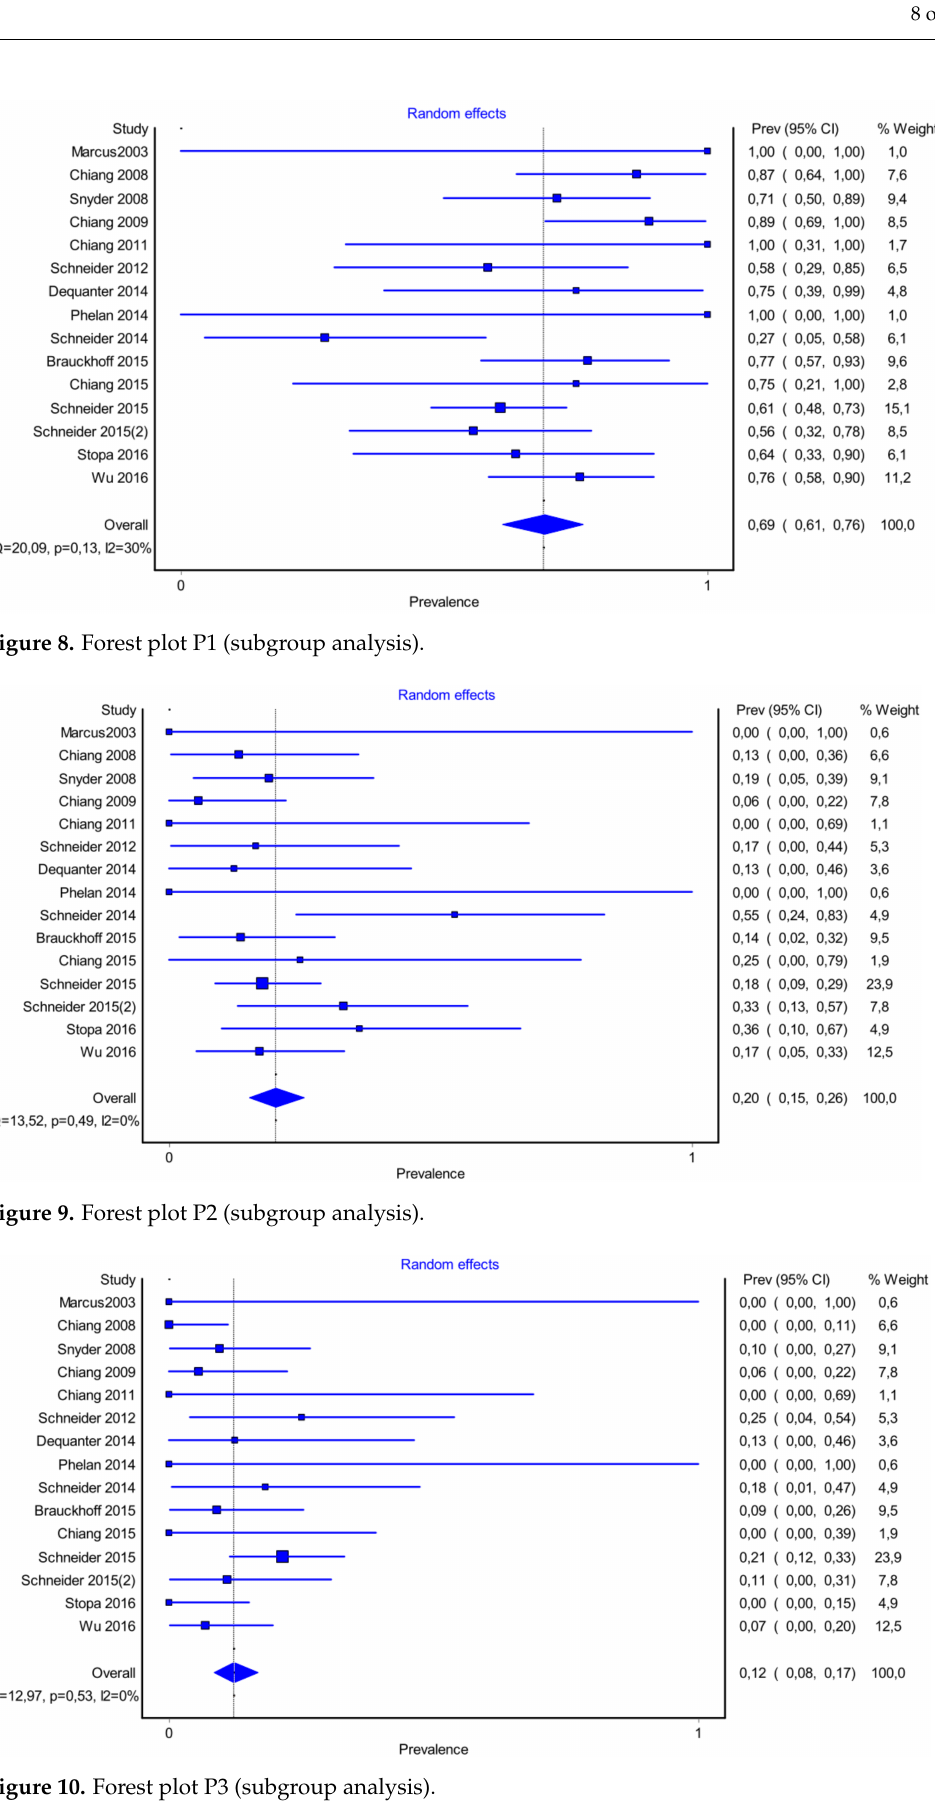
Figure 10. Forest plot P3 (subgroup